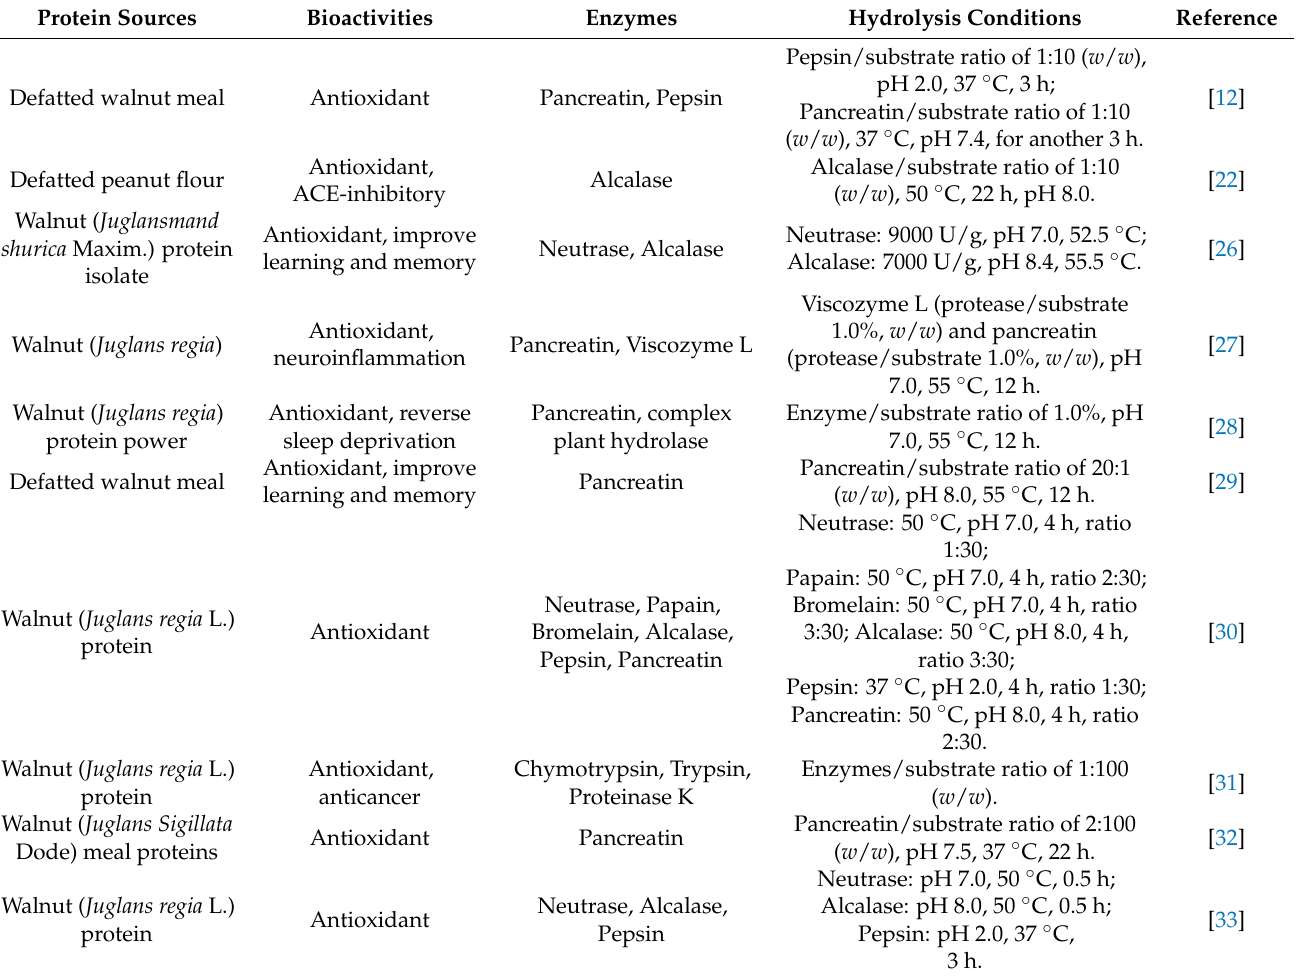
Table 2. Antioxidative hydrolysate of nut protein prepared by enzymatic